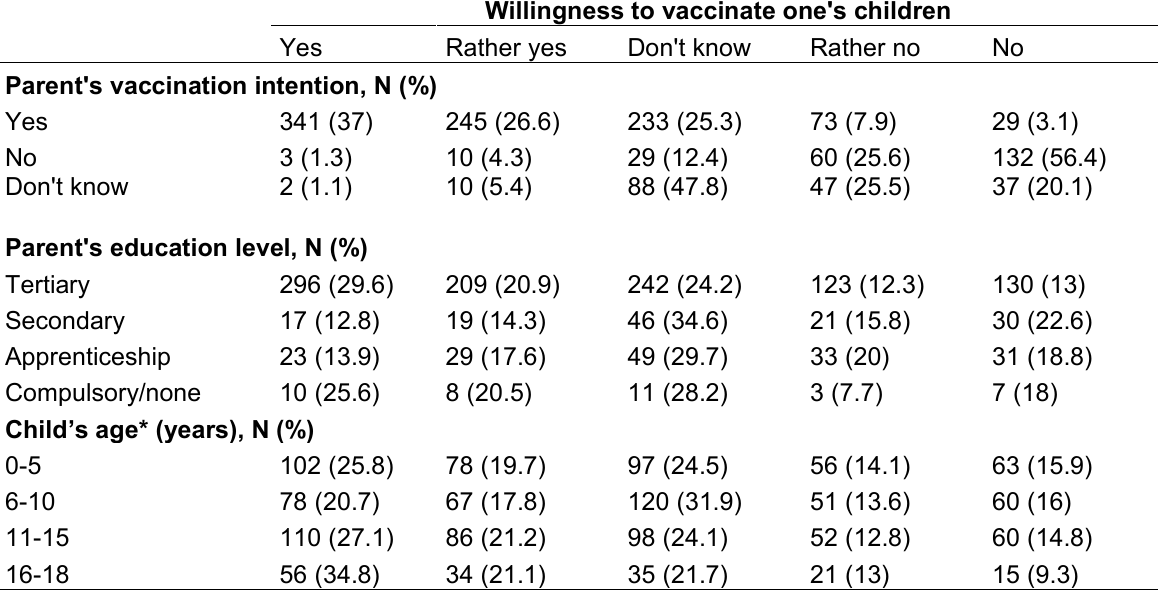
Table S3. Willingness to vaccinate one’s children (N=1’339) stratified by parents’ vaccination, education level and child’s